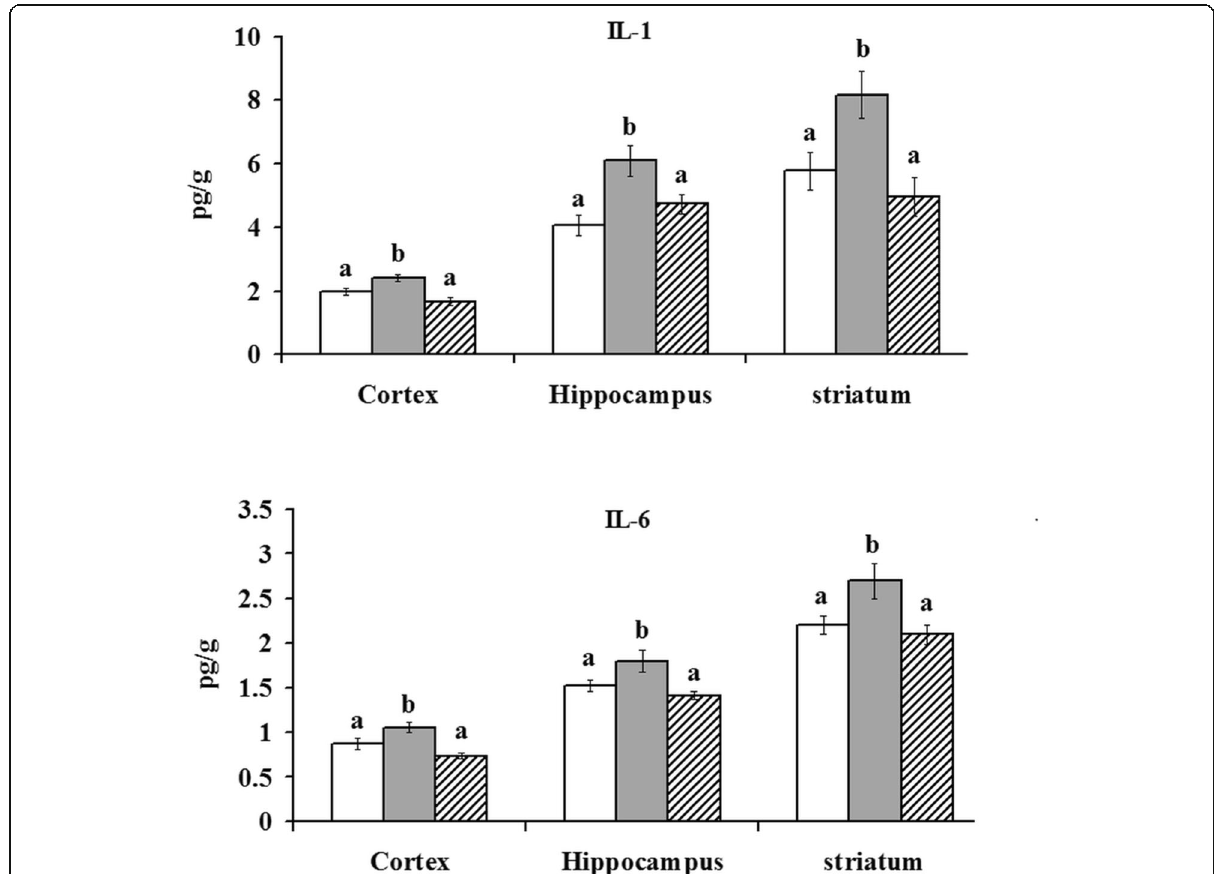
Fig. 2 The Effect of daily protection with frankincense oil (1000 mg/kg/day for 5 days) on the levels of Interleukin-1 β (IL-1 β ) and Interleukin-6 (IL- 6) in the cortex, hippocampus and striatum in rat model of status epilepticus (SE). Control Rat model of